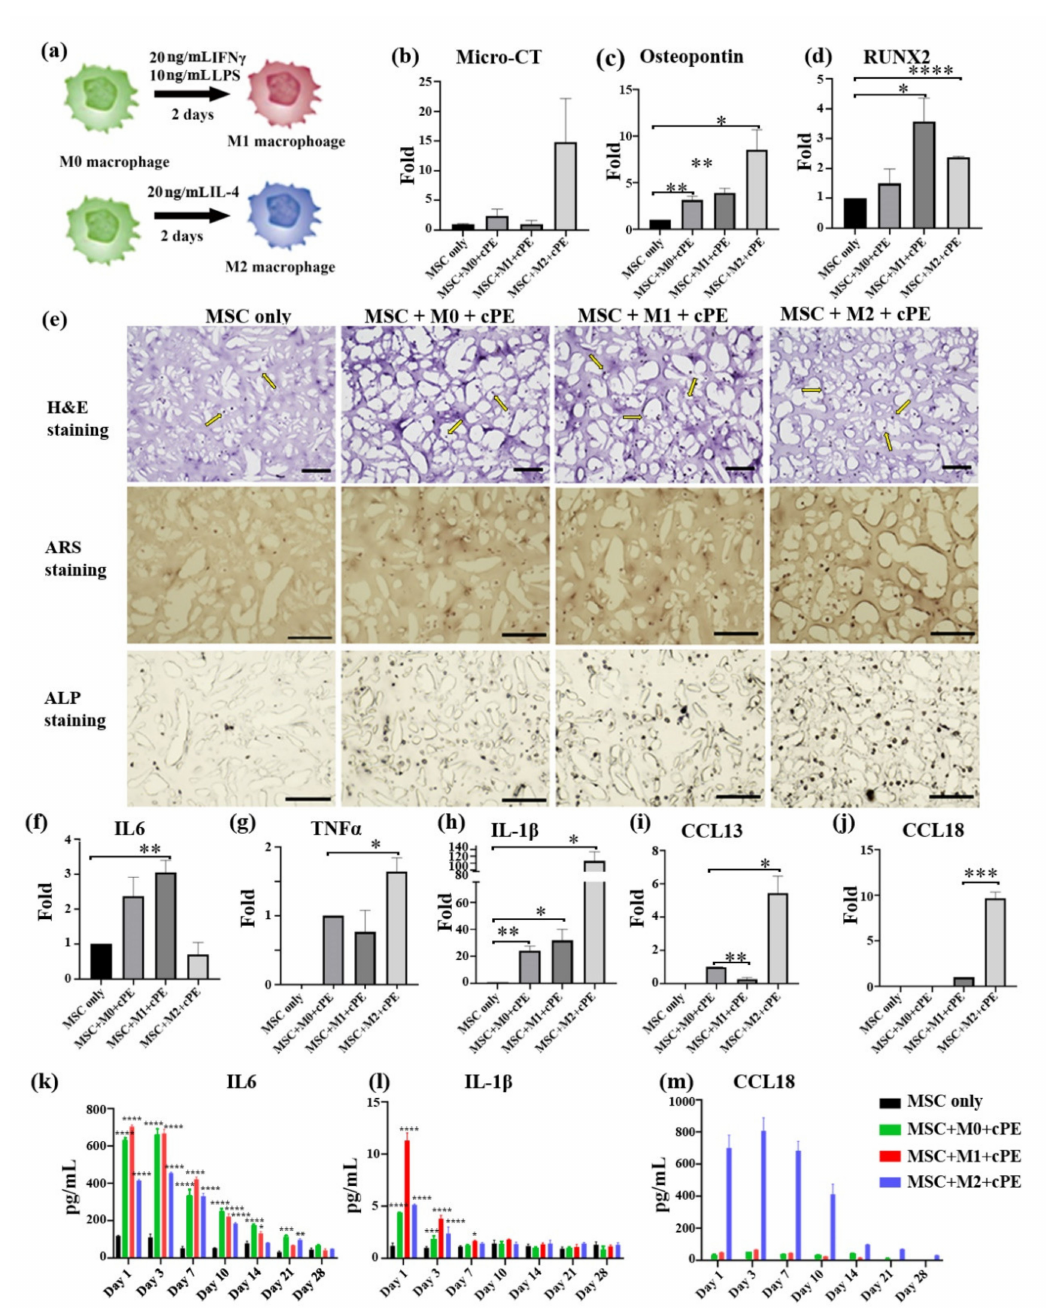
Figure 3. Effects of macrophage polarization on MSC osteogenesis in a cPE environment. M2 macrophages protect the particle-associated effects. ( a ) Schematic of the polarization process. M0, M1, and M2 macrophages were co-cultured with MSCs and cPE. ( b ) Mineralization of the tissue was measured by micro-CT. ( c , d ) qPCR data of osteogenic gene expression. ( e ) H&E, ARS, and ALP staining after 4 weeks of osteogenic differentiation (scale bar 100 µ m). Yellow arrows indicate cells. ( f – j ) qPCR was used to evaluate the expression of IL6 , TNF α , IL-1 β , CCL13 , and CCL18 . ( k – m ) Secreted cytokines were detected by ELISA. The MSC-only group was selected as the control group. (* p < 0.05, ** p < 0.01, *** p < 0.001, **** p <